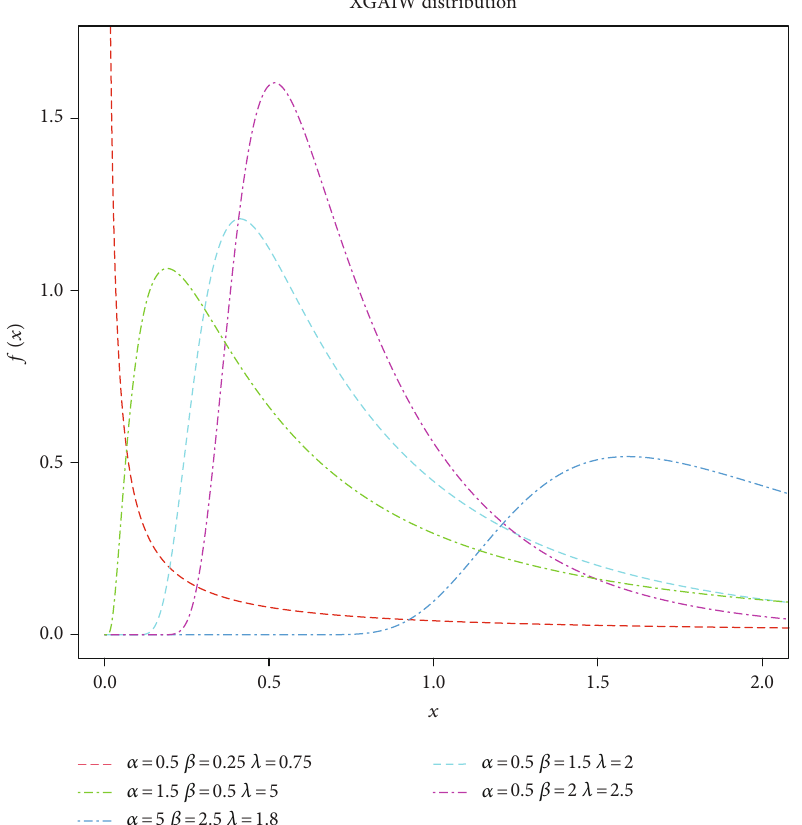
Figure 1: Plots of the PDF of the XGAIW distribution for di ff erent values of parameters.